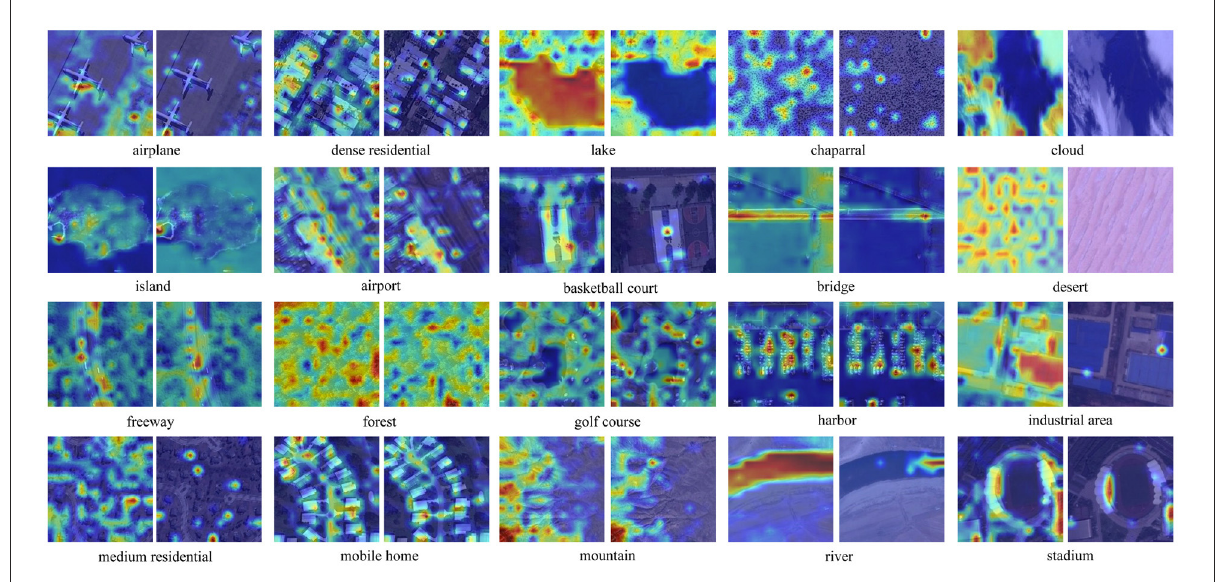
FIGURE8 Energy map visualization for GSC-MIM (left) and DINO (right)